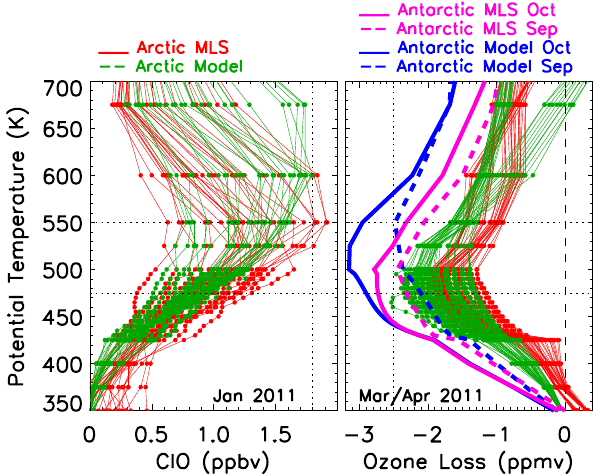
Fig. 8. ClO (left) and ozone loss (right) profiles inside the vor- tex from Mimosa-Chim (green) and MLS (red) in the Arctic win- ter 2010/2011, and the mean September and October ozone loss profiles in the Antarctic vortex averaged for seven winters (2004– 2010). The dotted vertical line is 1.8ppbv of ClO or 2.5ppmv of ozone loss. The dashed vertical line is 0ppmv. The dotted horizon- tal lines are 475K and